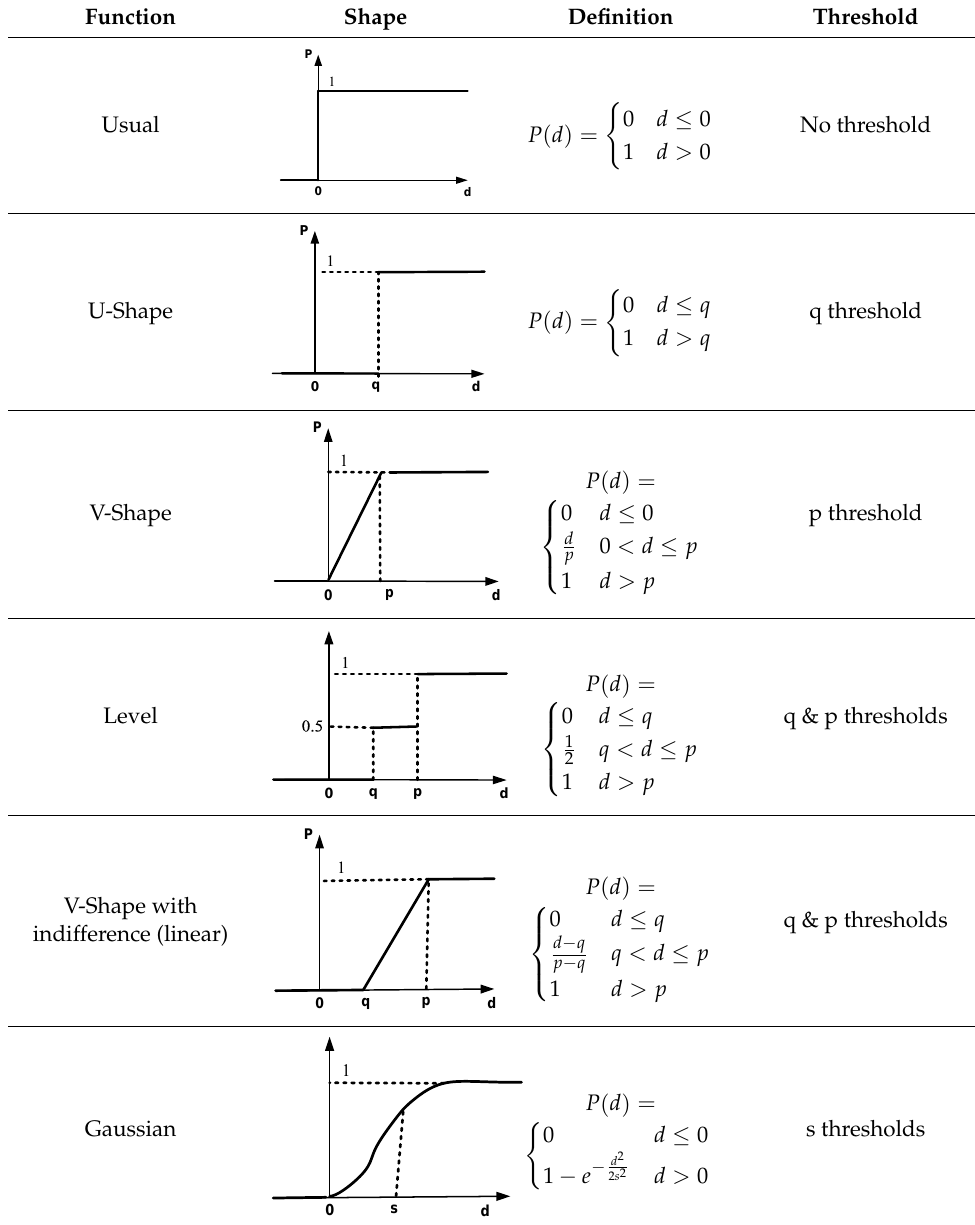
Table 1. Preference functions of the PROMETHEE technique.